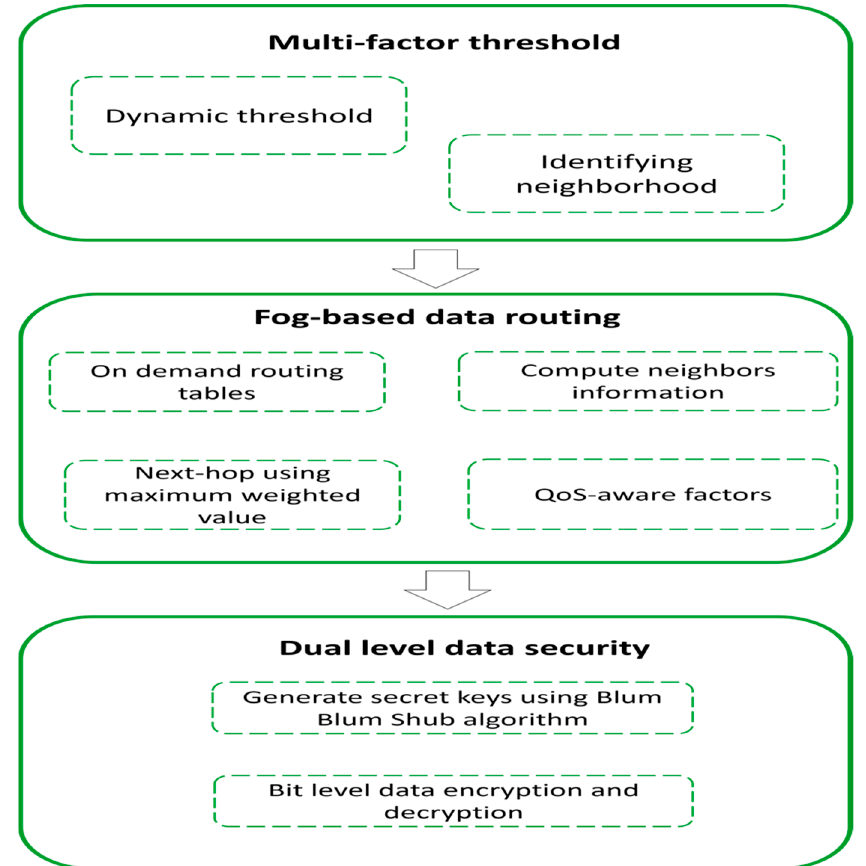
Figure 1. Architectural design of the proposed work.